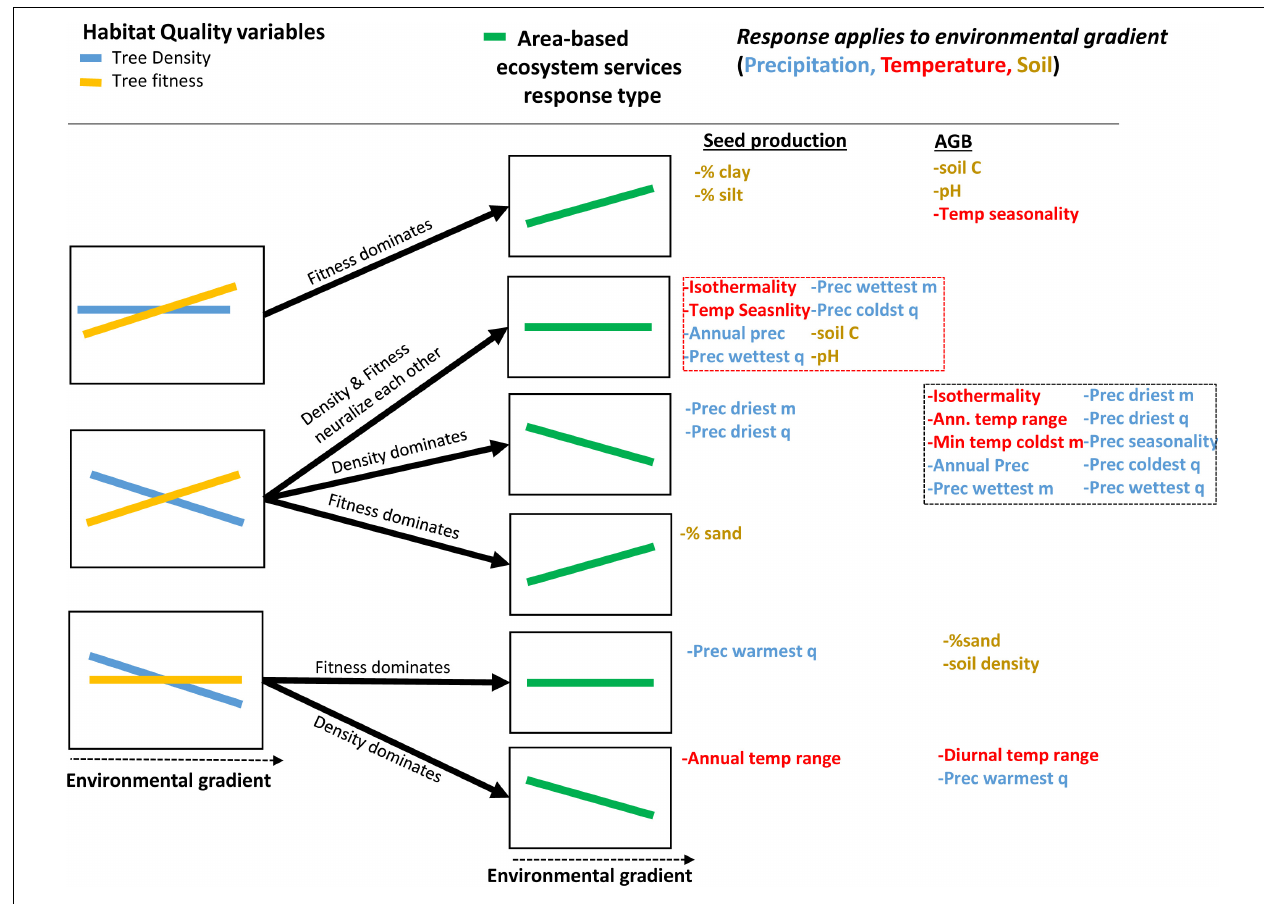
FIGURE 6 | Relations between area-based ecosystem services (SP a and AGB a ) and environmental gradients (green line graphs), as the net result of relations between tree-centric (SP t and AGB t ) and area-based (tree density) habitat quality variables (orange and blue line graphs) and those environmental gradients. The black arrows indicate which of the habitat quality variables (i.e., fitness or density) dominated the relation between area-based ecosystem services and the environmental gradients corresponding to the different climate, soil, and terrain variables listed on the right-hand side. Only environmental gradients that generated non-congruent responses of tree-centric and area-based habitat quality variables are represented (see Table 2 ). Note that “flat” lines indicate non-significant relations, while “inclined” lines indicate significant relations, but these can refer to either a positive or negative relation. For meaning of dashed red and black boxes, please refer to the text. As an example, the response to annual precipitation (listed in dashed red box on the right-hand side) of area-based seed production is invariable (2nd green graph from top), which is the result of the positive and negative responses of density and tree-centric seed production, respectively, which neutralize each other (central graph on the left-hand side). By contrast, annual precipitation (listed in lower dashed black box on the right-hand side) generates a negative response of area-based AGB (3rd green graph from top), because the negative correlation of tree density with precipitation dominates the positive one of tree-centric AGB (central graph on the left-hand side). This same example is also illustrated in Figure 7